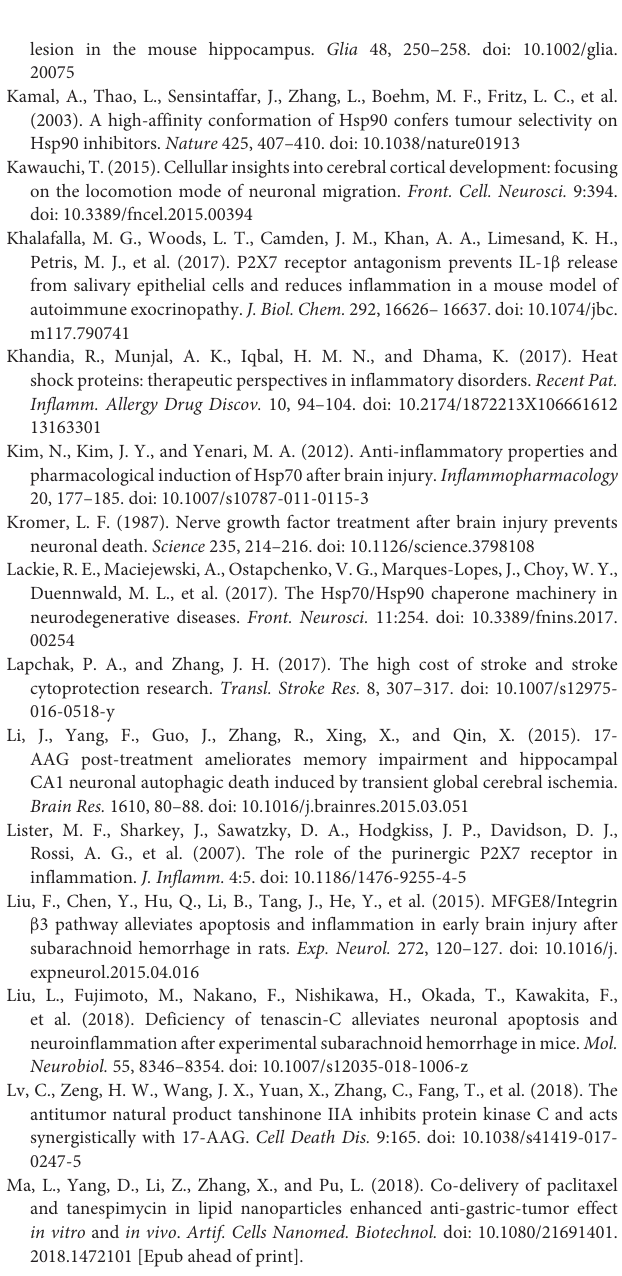
FIGURE S1 | Experimental design and the number of mice used in each group. (A) Designs of Experiments 1–6. (B) Numbers of mice used and mortality in each group. ∗ Animals shared with the sham group in experiment 1; # animals shared with the SAH + vehicle group in Experiment 3. FIGURE S2 | Expression of HSP70 and HSP40 after subarachnoid hemorrhage (SAH) and affected by 17-AAG treatment. (A) Representative western blot images and quantitative analyses of the (B) HSP70 and (C) HSP40 time course in the left hemisphere after SAH. (D) Representative western blot images and quantitative analyses of the (E) HSP70 and (F) HSP40 after 17-AAG treatment in the left hemisphere after SAH. The expression of HSP70 increased after SAH, and administration of 17-AAG can further increased the HSP70 protein level. However, the HSP40 protein level showed no significant difference after SAH and not affected by 17-AAG treatment. n = 6 per group. ns, no significant. ∗ P < 0.05 vs. sham; # P < 0.05 vs. SAH + vehicle. The error bars represent SD.